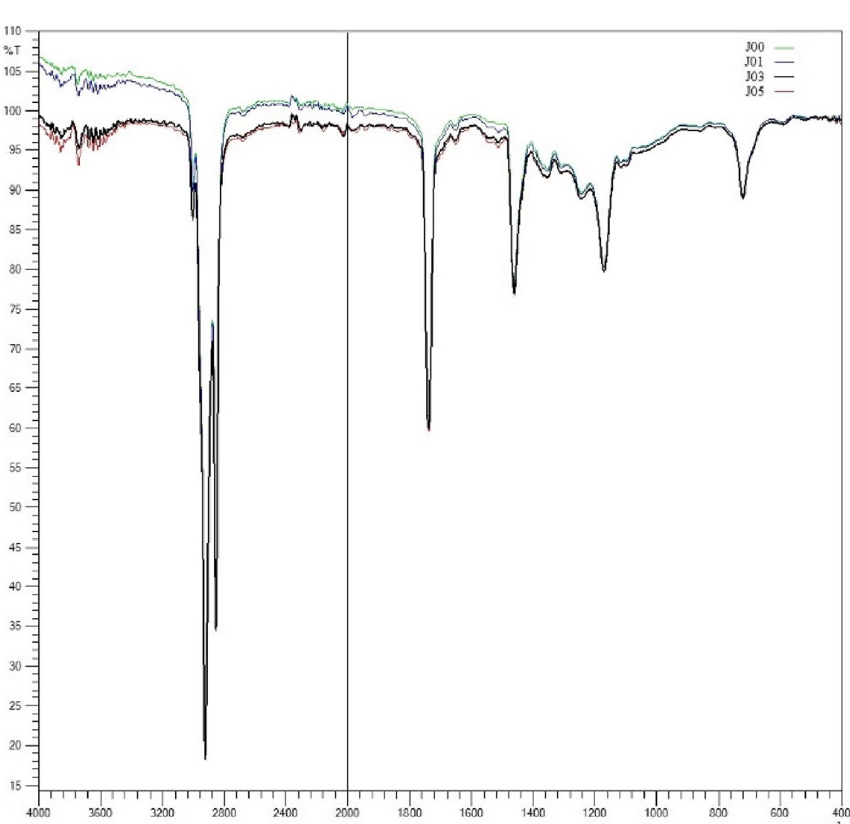
Fig. 6 FT-IR spectrum of oil